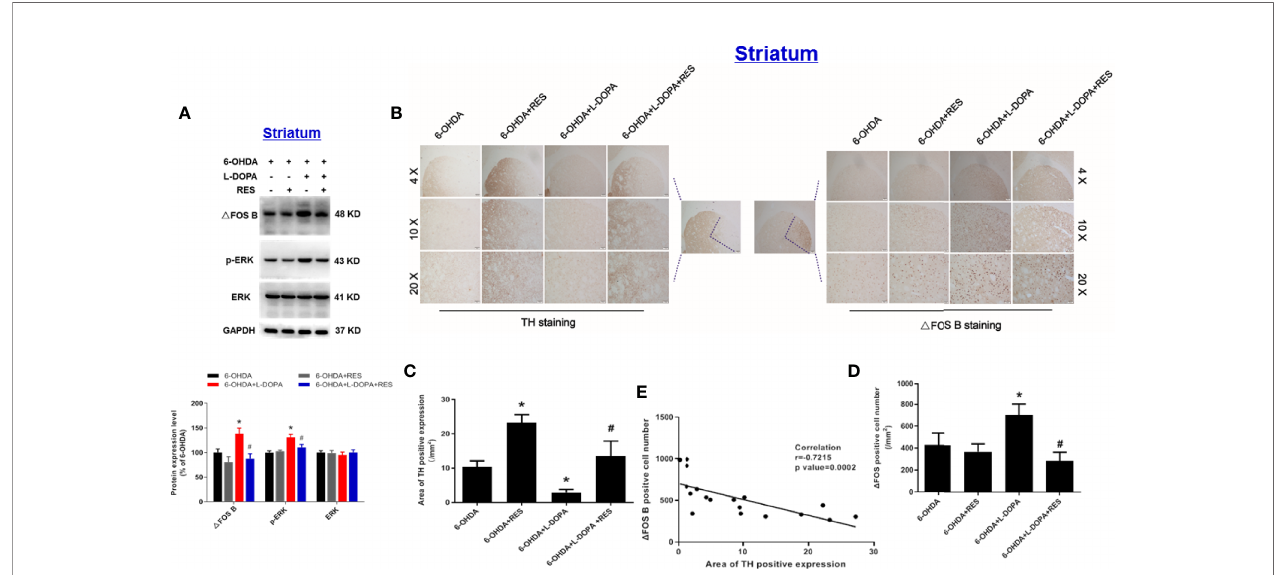
FIGURE 4 | Analysis of the correlation between DA neuronal damage and dyskinesia marker D FOS B level in the striatum of rats with LID. After 42 days of L-DOPA treatment, the expression levels of D FOS B, phosphorylated-ERK (p-ERK) and ERK proteins in the striatum of rats were analyzed by western blotting. The densitometry values of TH, phosphorylated ERK (p-ERK) and ERK were detected and normalized to GAPDH of the same group. Then, data were normalized and calculated as a percentage of each respective 6-OHDA group (A) . Next, the expression of TH from DA projection fi ber and D FOS B in the striatum of rats were detected by immunohistochemistry staining (B) . Area of TH-positive expression was measured (C) . D FOS B-positive cell number was quanti fi ed (D) . The correlation between the expression of TH and D FOS B was analyzed (E) . Data were expressed as mean ± SEM from 5 rats. * P < 0.05 compared with 6-OHDA group; # P < 0.05 compared with 6-OHDA+L-DOPA